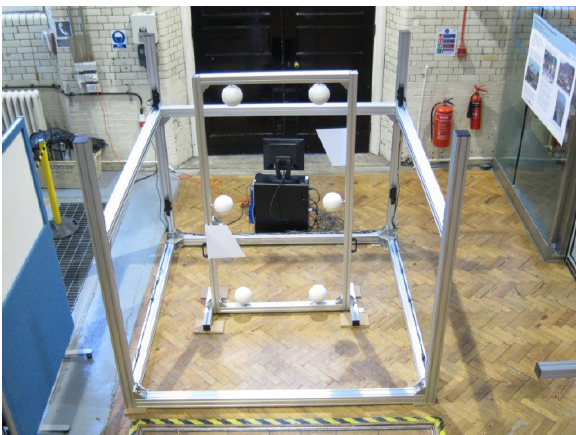
Figure 7. A prototype of a full body scanner integrating eight ASUS Xtion Pro NUI sensors in the corners of a cubical frame.